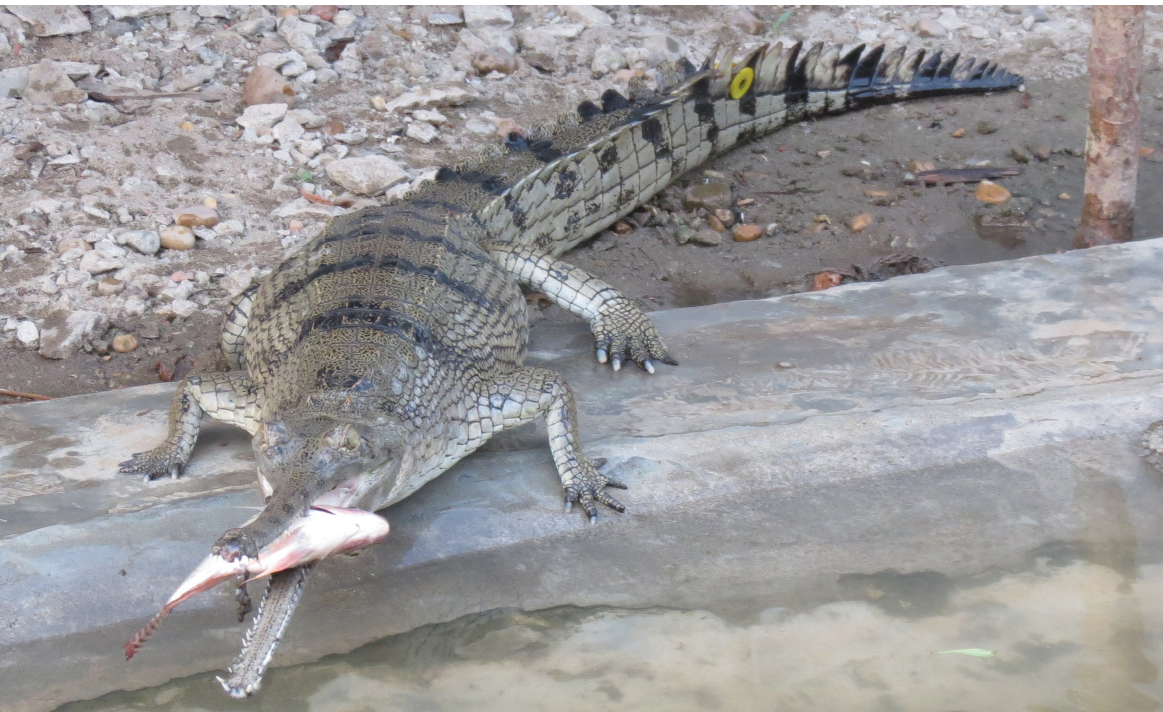
Image 2. A close–up picture of tagged Gharial feeding on fish at the Gharial Conservation and Breeding Center, Chitwan National Park, Nepal. Photograph by Bed Bahadur Khadka taken on 4 April